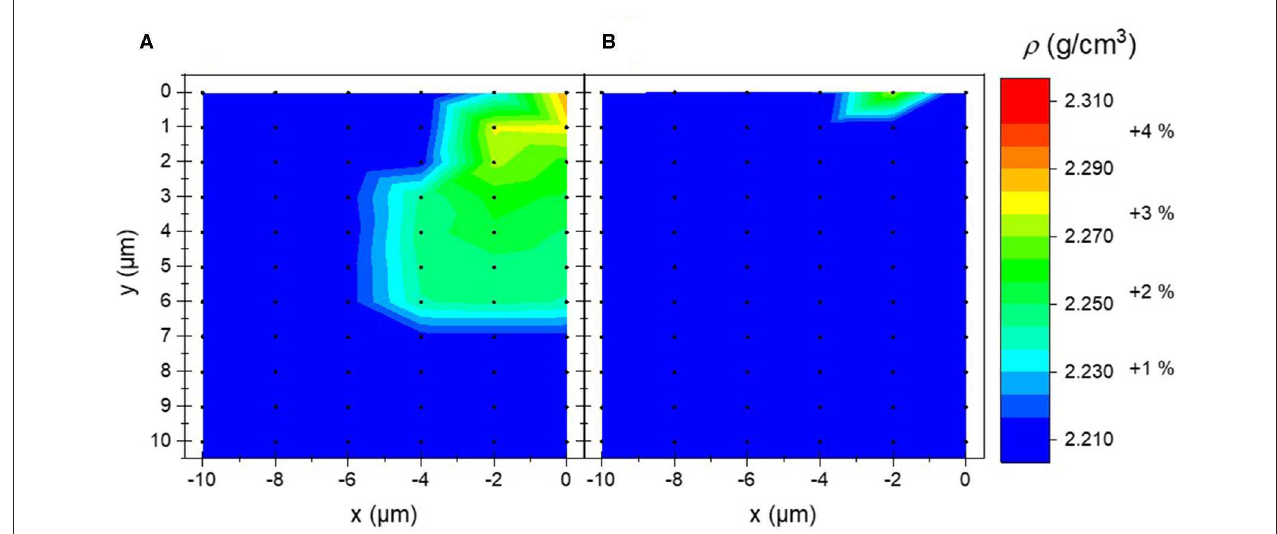
FIGURE 5 | Density map as derived from the maximum position of the FSDP for indent 1 using the calibration curve in Eq. 1 (Tan and Arndt, 1999): (A) in-situ during indentation; (B) after unloading. Contour diagrams of density ρ were constructed from interpolation between the individual measurement positions (black